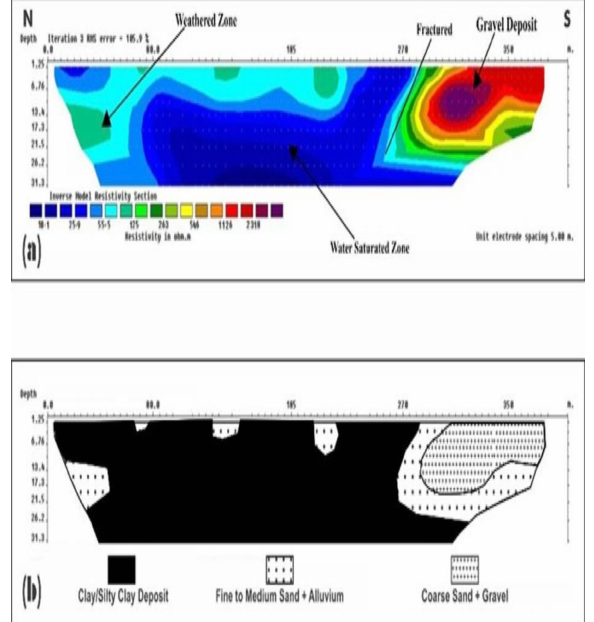
Fig. 8. (a) Profile 6 electrical resistivity tomography; (b) Geologic cross-section interpreted from the resistivity model within a sequence of horizontal sedimentary sequence (see Fig. 3).